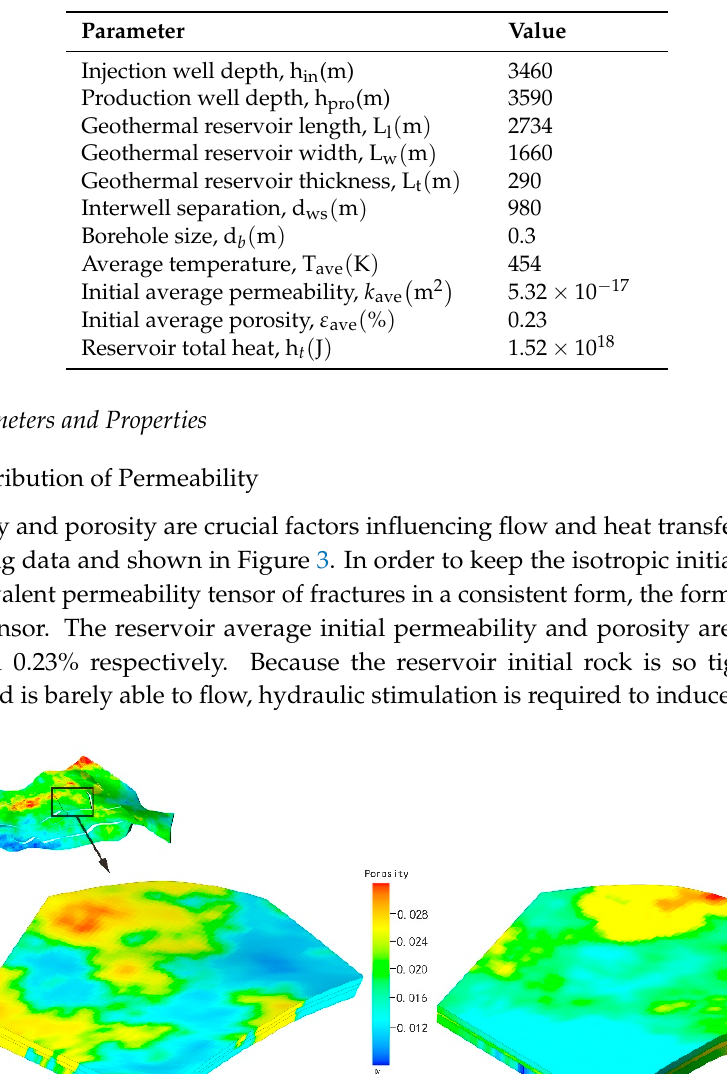
Table 1. Model geometric dimension and geophysics parameters.